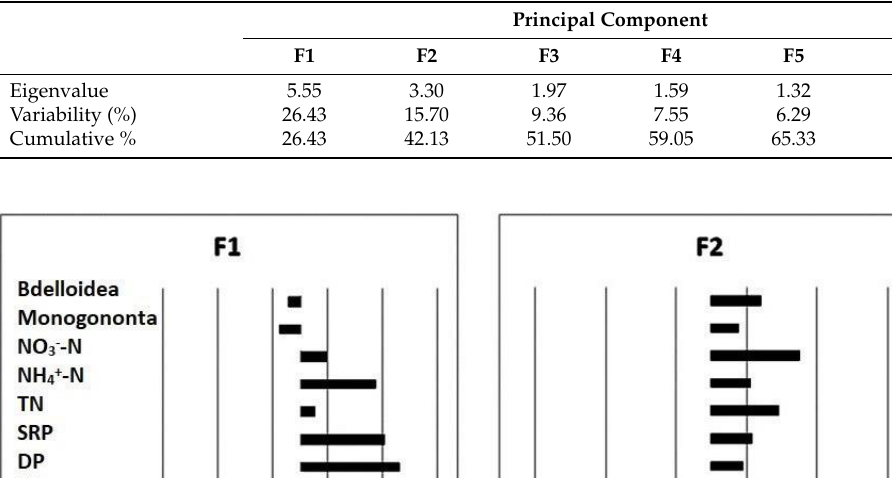
Table 4. Eigenvalues, variance and cumulative variance of the principal components of water chemical parameters of springs in Knyszyn Forest.